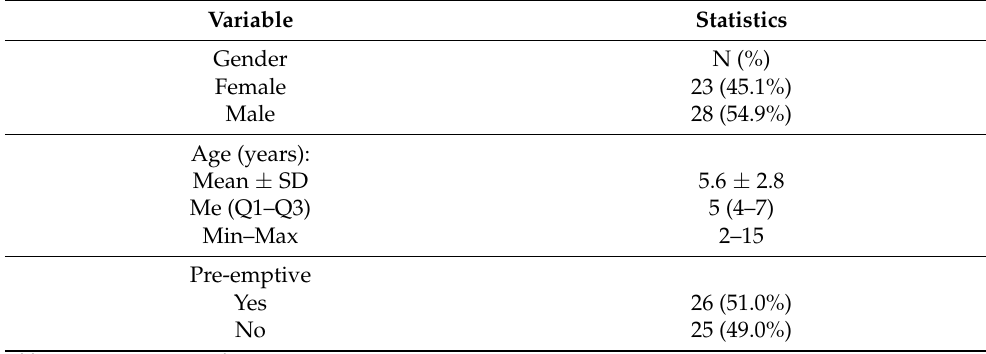
Table 1. Characteristics of the studied children.